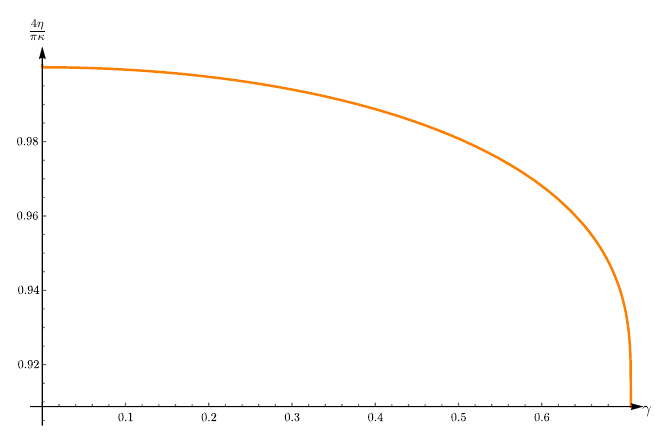
Figure 7 . Plot of 4 η/ ( πκ ) as a function of γ , see eq.